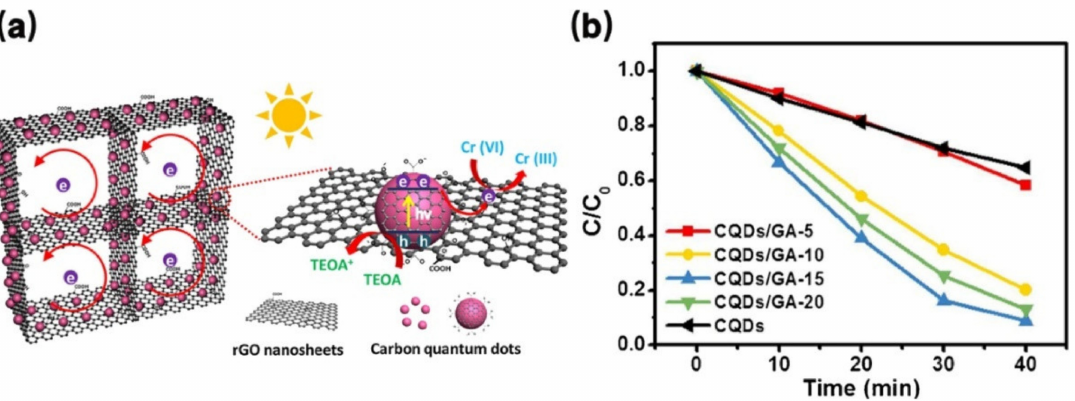
Figure 15. ( a ) Photocatalytic mechanism of the 3D CQDs/GA composites. ( b ) Photocatalytic reduc- tion of Cr (VI) with different proportions of CQDs/GA and original CQDs